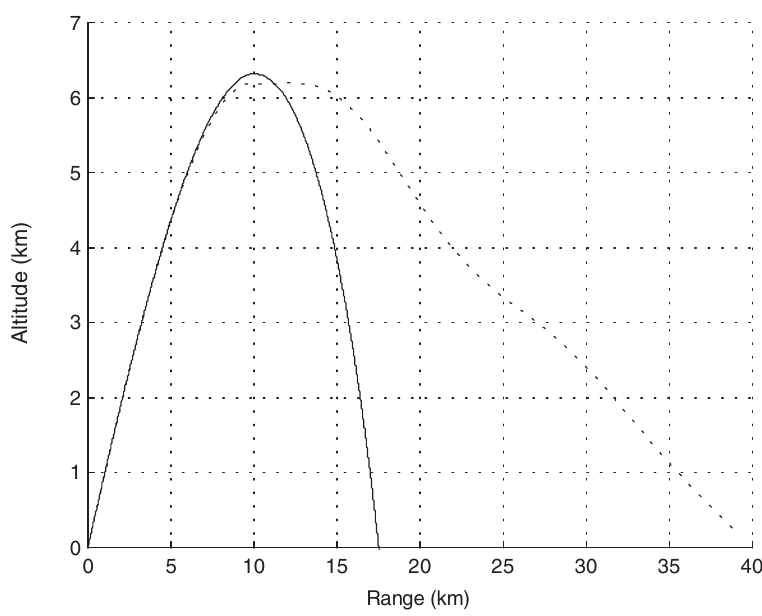
Fig. 6. Altitude vs. range (Solid = Nominal, Dotted =